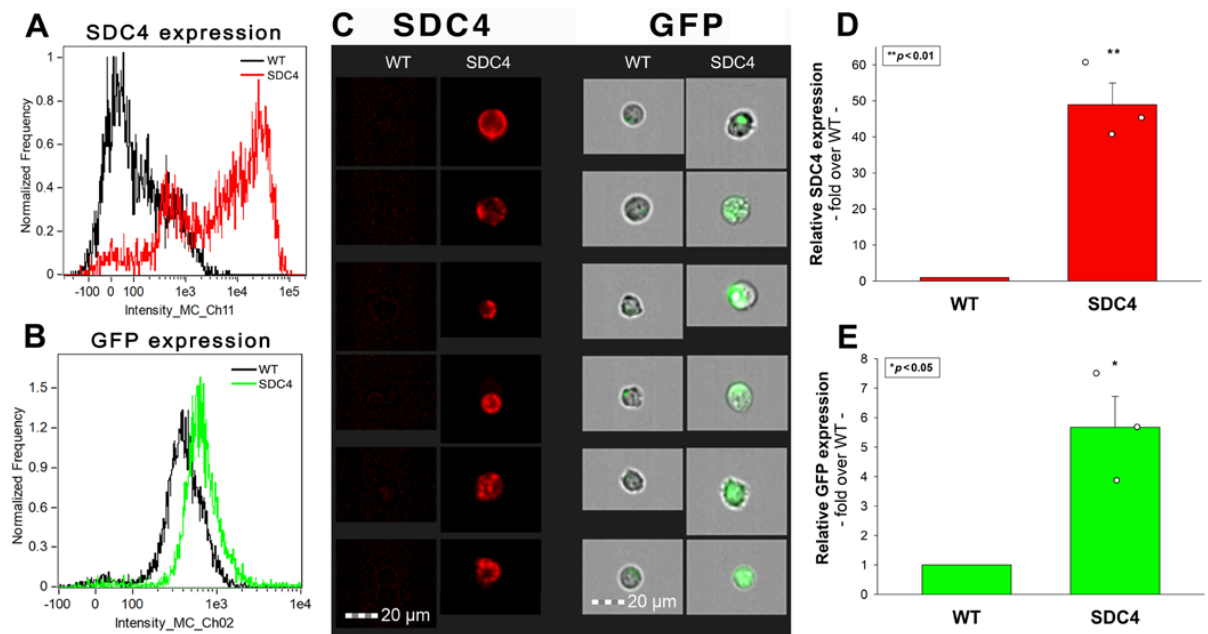
Figure 6. SDC4 overexpression increases AAV9-mediated GFP transduction in SH-SY5Y cells. SDC4 transfectants (created in SH-SY5Y cells) and WT SH-SY5Y cells were incubated with AAV9-GFP (4 × 10 4 vg/cell) at 37 °C for 72 h. GFP expression was then analyzed with imaging flow cytometry. ( A – C ) Representative flow cytometry histograms and fluorescent images showing the GFP and SDC4 expression levels in WT SH-SY5Y cells and SDC4 transfectants treated with AAV9-GFP. Scale bar = 20 μm. ( D , E ) Detected SDC4 and GFP expression levels of AAV9-treated SDC4 transfectants were normalized to that of WT SH-SY5Y cells as standards. The bars represent the mean + SEM of three independent experiments. Statistical significance vs. standards was assessed with ANOVA. * p < 0.05; ** p < 0.01.